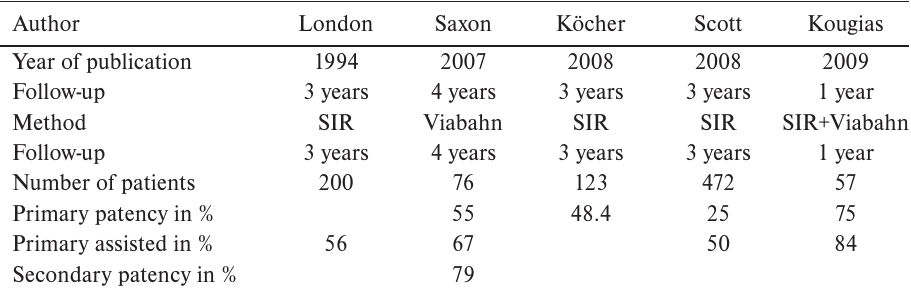
Table 3. Results of endovascular